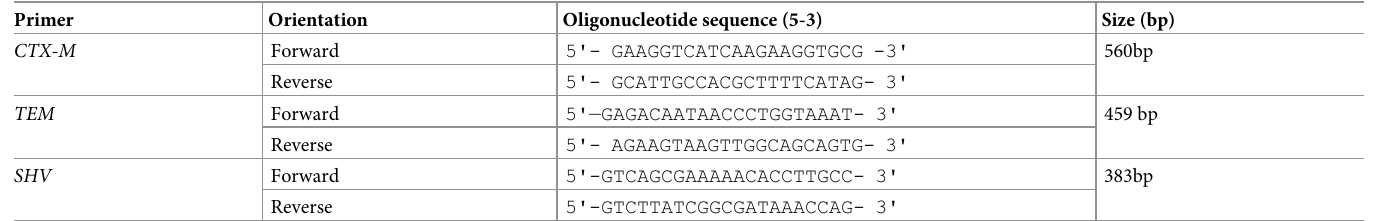
Table 1. Primers for polymerase chain reaction of ESBL genes.